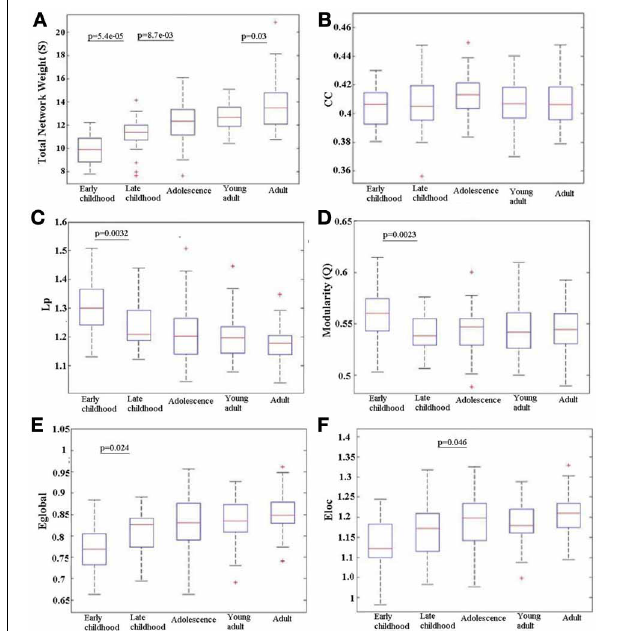
FIGURE 4 | Age-related changes in different network metrics for the developing WM network from early childhood to adult. (A) Total network strength (S), (B) Clustering coefficient (CC), (C) Shortest path length (L p ), (D) Modularity (Q), (E) Global efficiency (E glob ), and (F) Local efficiency (E loc ). Significant changes between any adjacent age groups are indicated by their p value. An increase with age is observed in S over the full age span. E glob increases only between the two youngest age groups and E loc only between late childhood and adolescence; in both cases, the efficiency values then stay elevated. Reductions are observed in L p and Q from early to late childhood that is then maintained low. There is no change in CC between any adjacent age groups. The + signs indicate